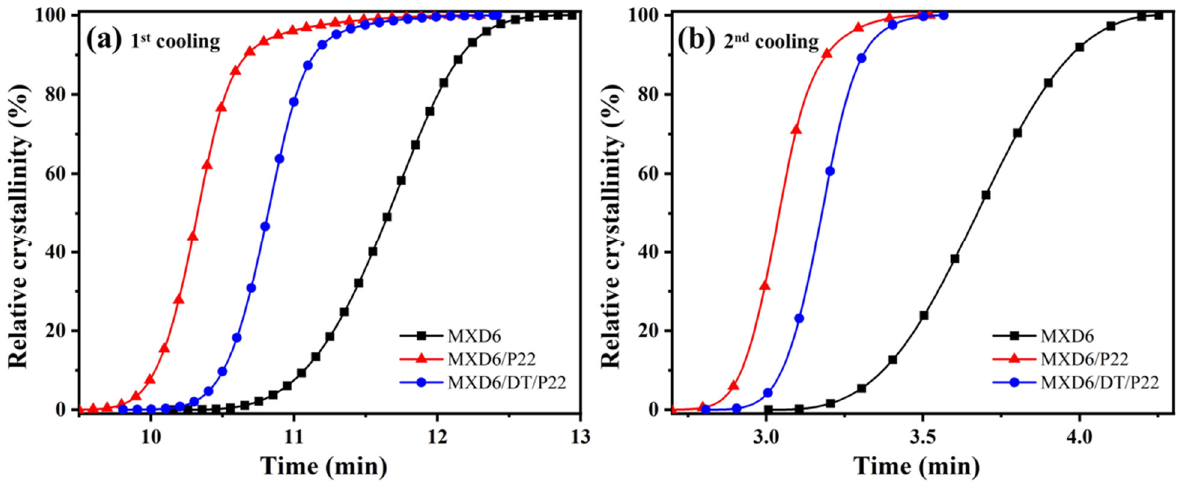
Figure 2. Relative crystallinity vs. time at different cooling rates: ( a ) 10 °C/min and ( b ) 40 °C/min of neat and modified MXD6.